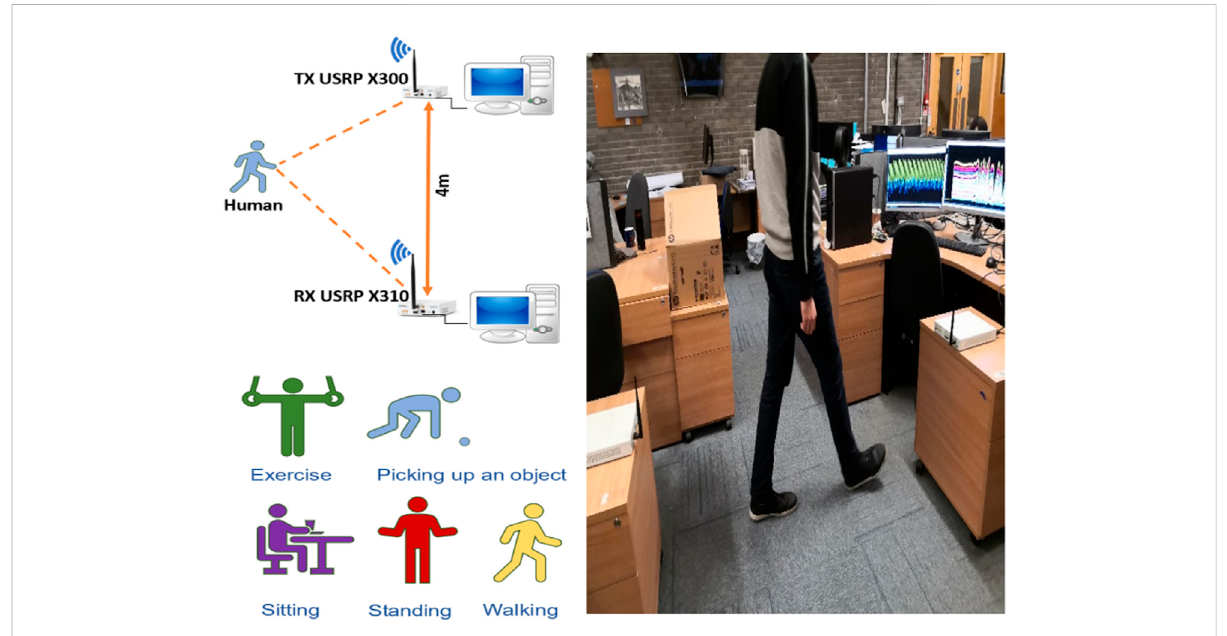
FIGURE 15 Experiment setup of activity monitoring using Wi-Fi signals (Ashleibta et al., 2020).